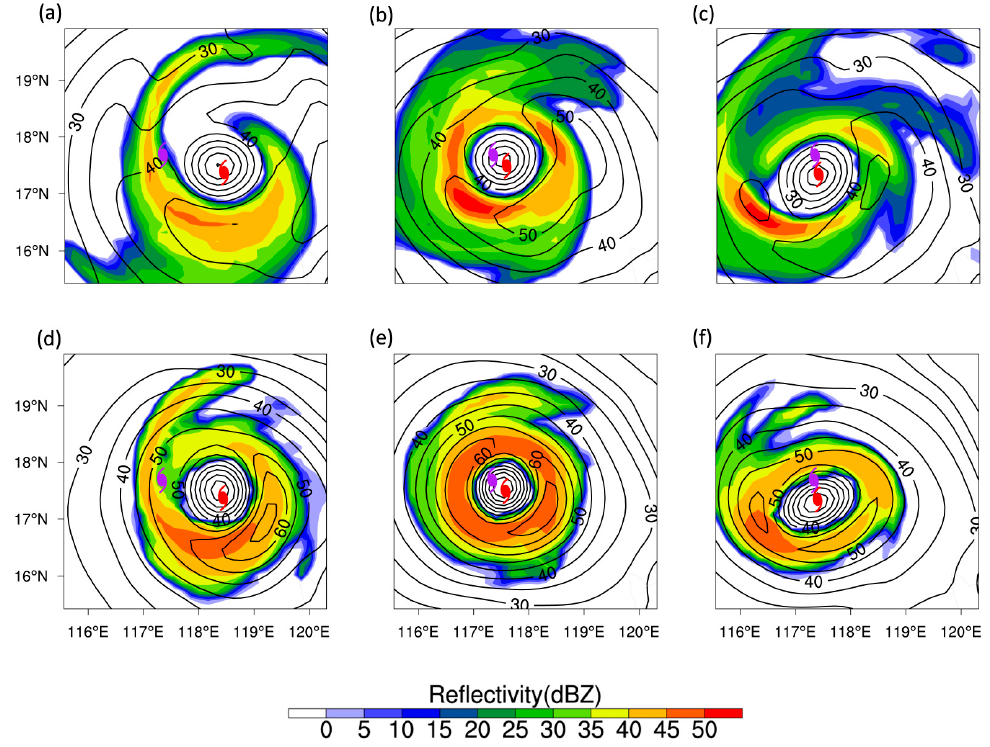
Figure 7. Distribution of radar reflectivity (dashes, units: dBZ) and wind speed (solid lines, units: m s − 1 ) by CTRL ( a , d ), SN1 ( b , e ), SN3 ( c , f ) at 500 hPa ( a – c ) and 850 hPa ( d – f ) at the deflection moment (0600 UTC 20); red typhoon symbols represent the simulated typhoon centers while purple typhoon symbols represent the observed typhoon centers.